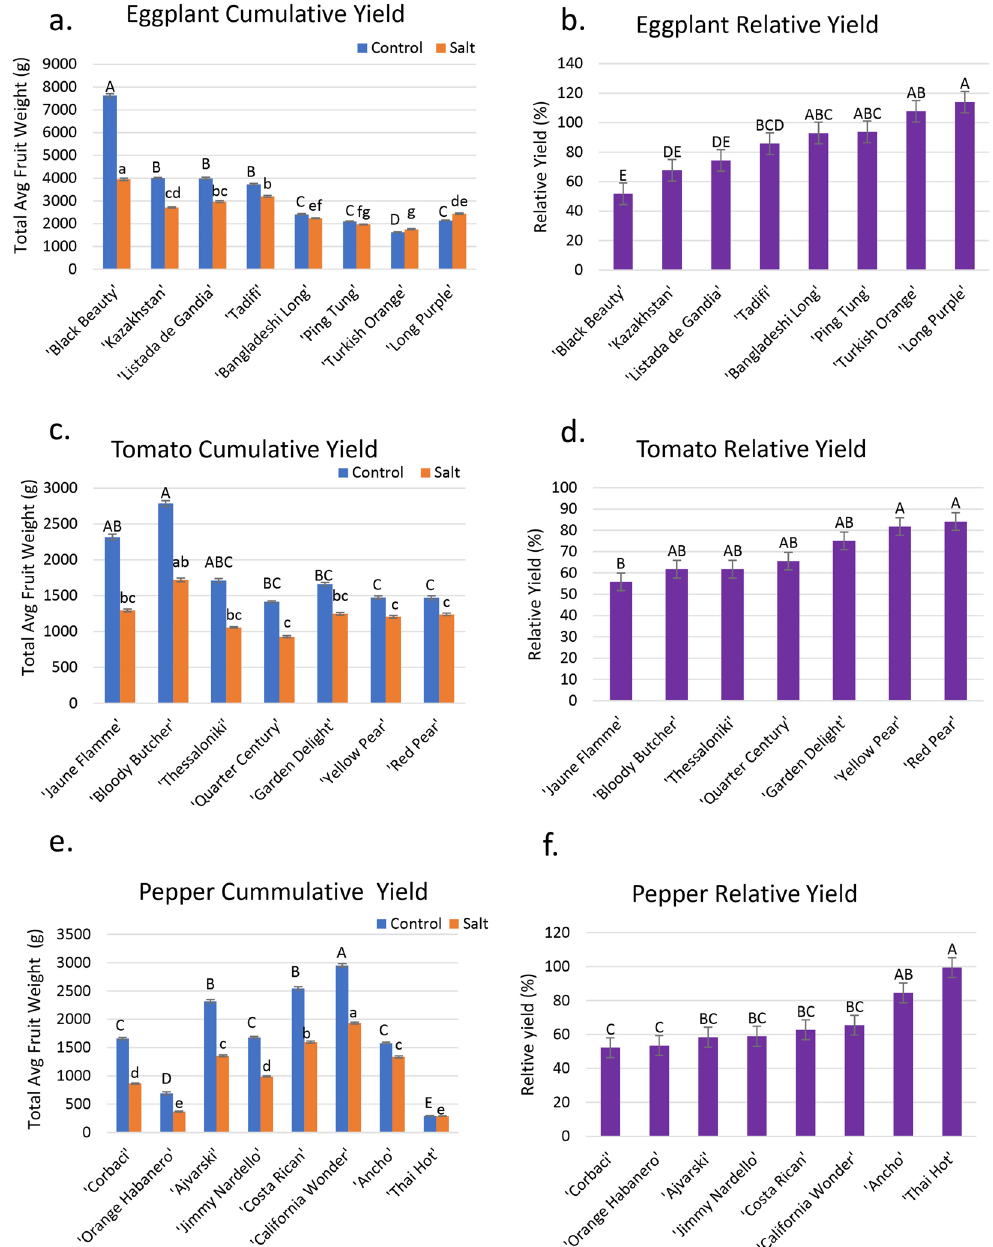
Figure 1. Fruit yield of eggplant, tomato, and pepper under control and saline irrigation waters. ( a ) Cumulative fresh weight fruit yield for 8 eggplant cultivars. ( b ) Relative yield (yield of saline treatment/yield of control) for 8 eggplant cultivars, expressed as a percent. ( c ) Cumulative fresh weight fruit yield for 7 tomato cultivars. ( d ) Relative yield for 7 tomato cultivars, expressed as a percent. ( e ) Cumulative fresh weight fruit yield for 8 pepper cultivars. ( f ) Relative yield for 8 pepper cultivars, expressed as a percent. Capital letters denote significant differences in yield under control conditions, while lowercase letters denote significant yield differences under saline conditions ( p < 0.05). Error bars represent standard